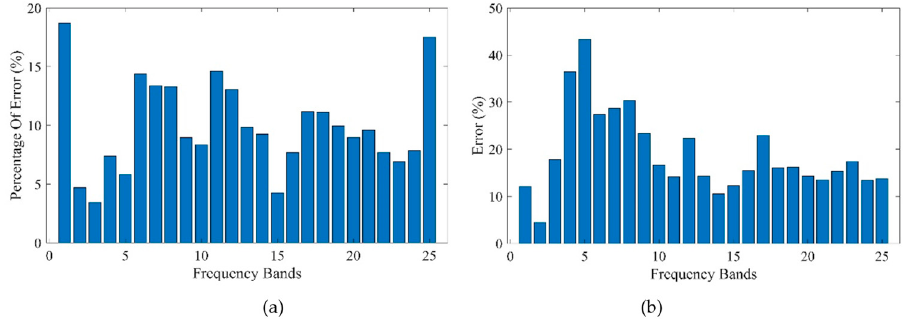
Figure 5. ( a ) Average of the percentage errors related to the frequency bands of position 1; ( b ) average of the percentage errors related to the frequency bands of position